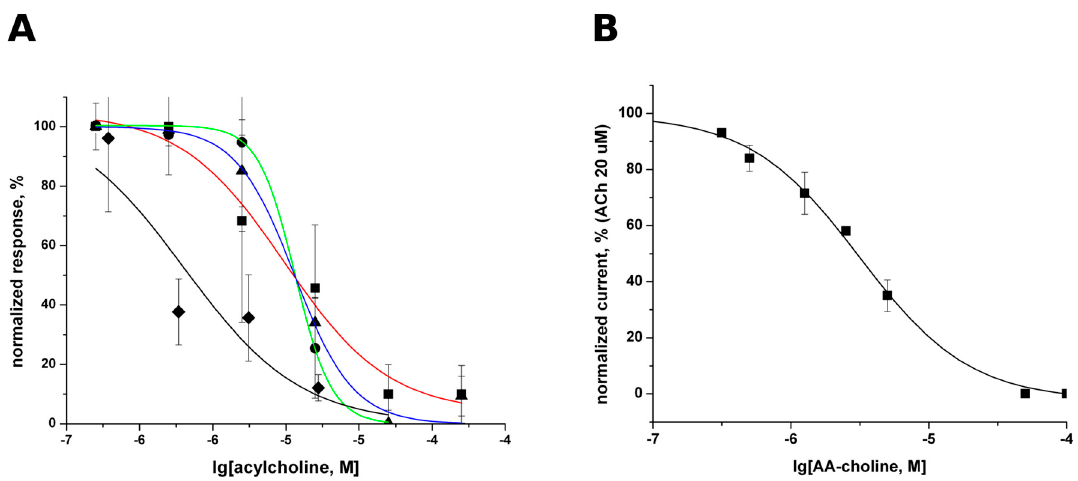
Figure 3. Inhibition of nAChR function by various acylcholines. ( A) Inhibition curves for AA-CHOL (red line, squares), Ol-CHOL (blue line, triangles), Ln-CHOL (black line, diamonds), and DHA-CHOL (green line, circles) of Ca 2 + influx evoked by acetylcholine in the presence of PNU 120596 on SH-SY5Y cell line. The IC 50 values are listed in Table 2; ( B) ACh evoked current in the mouse muscle nAChR expressed in Xenopus oocyte is inhibited by AA-CHOL at low micromolar concentrations (IC 50 3.16 ± 0.26 µ M). Table 2. Inhibition of acetylcholine-evoked Ca 2 + mobilization in SH-SY5Y cells in the presence of PNU 120596, IC 50 ( µ M). In the ANOVA with the Tukey post-hoc test, there were no statistically significant di ff erences. Acylcholine IC 50 ( µ M)